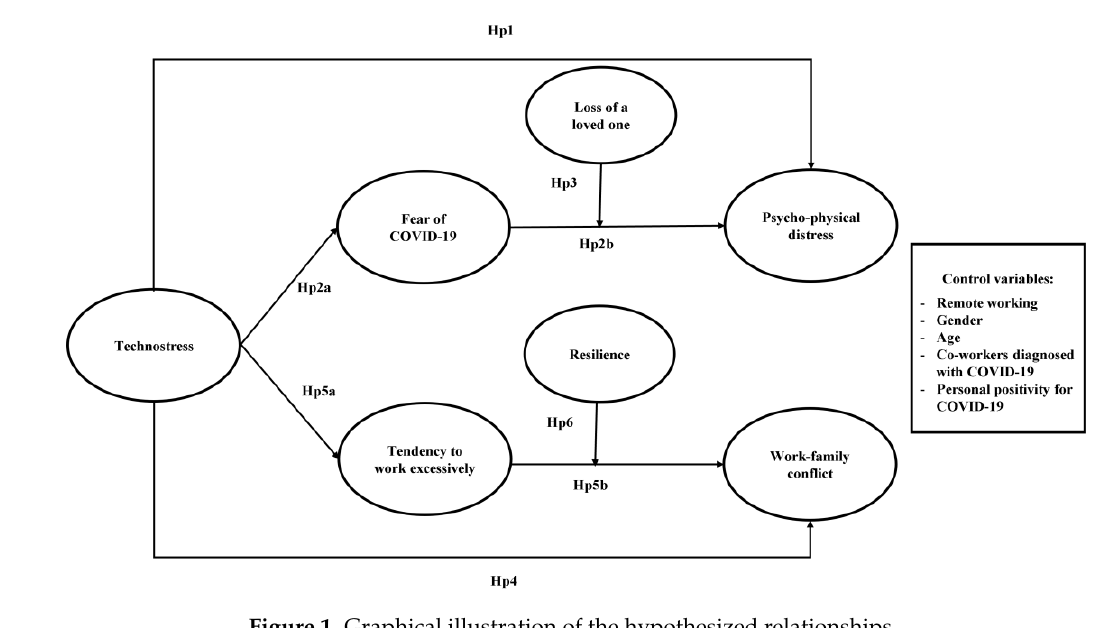
Figure 1. Graphical illustration of the hypothesized relationships .